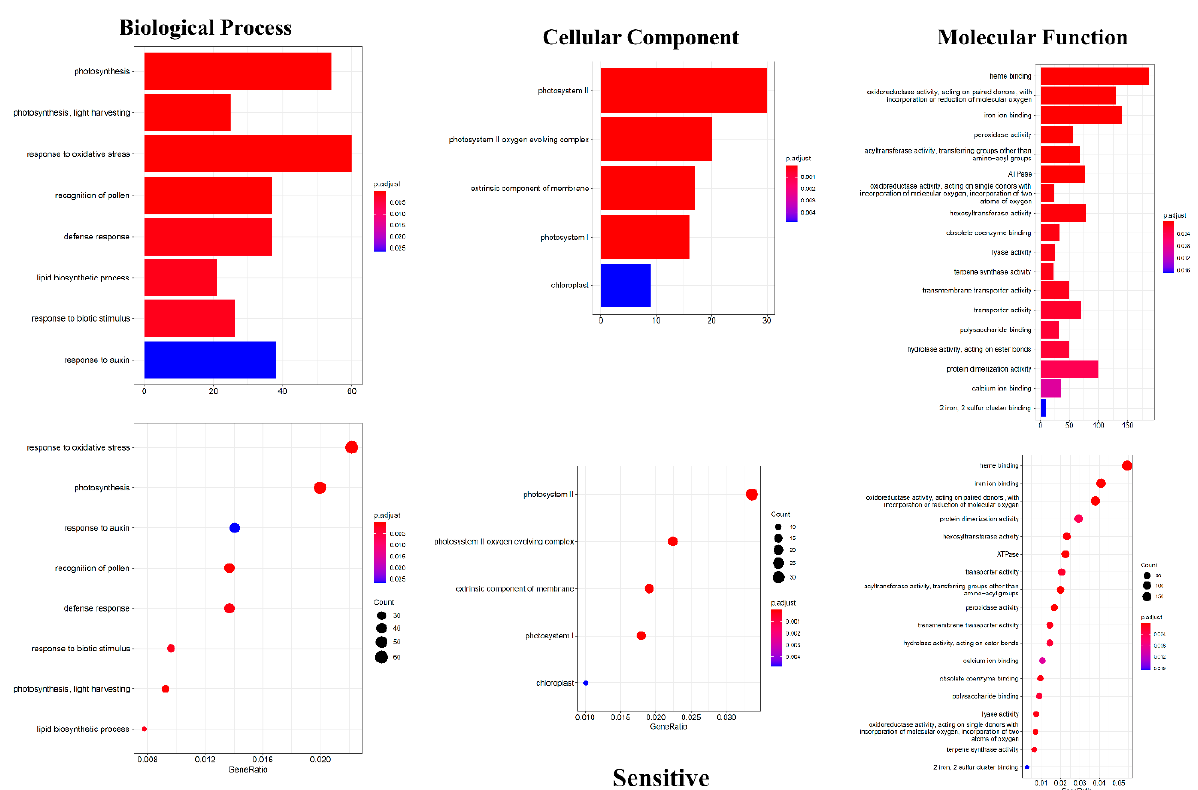
Figure 4. Based on gene ontology (GO) annotation, the root and leaf comparisons of tolerant and sensitive genotypes reveal DEG enrichment for biological processes, cellular components, and molecular functions. Gene ratios for enriched DEGs are included. The number of genes involved are plotted against each GO terms (Biological process, cellular components, molecular function). The DEGs were annotated against the GO database. The GO enrichment was based on the padj < 0.05.